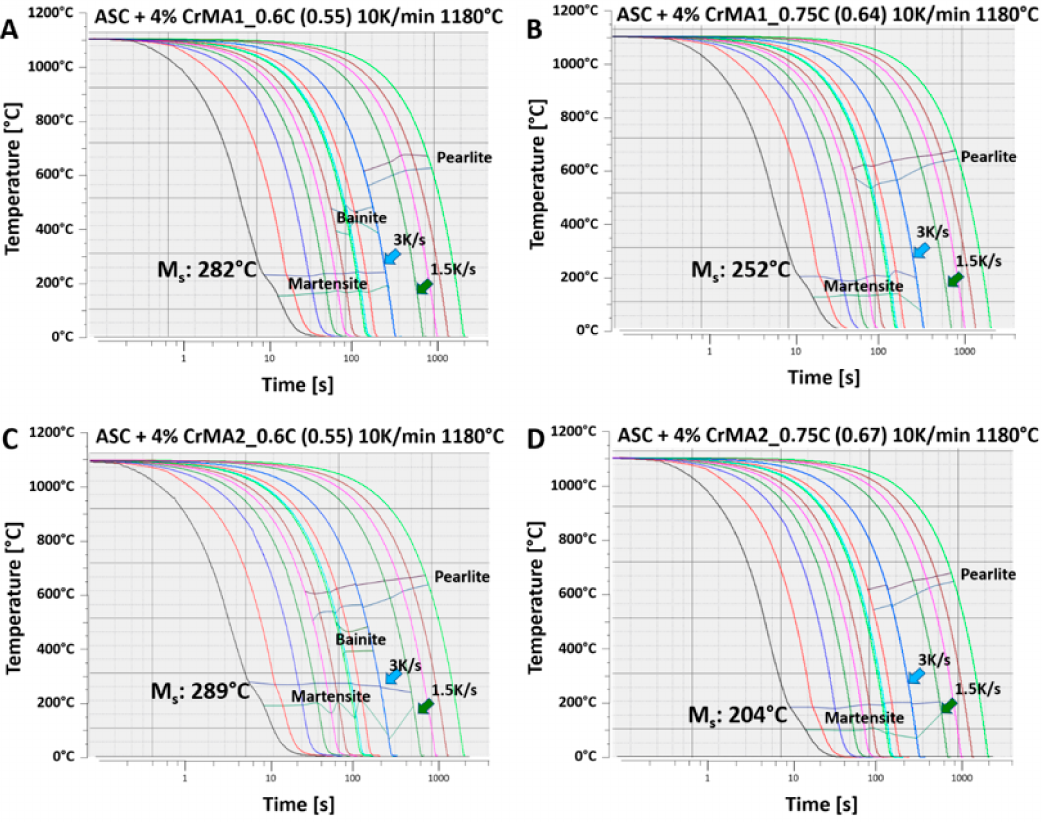
Figure 9. CCT diagrams recorded from a single sample with 14 runs each. Heated at 11 K/s to 1100 ◦ C and held for 300 s, cooled with different rates. (A) ASC + 4%CrMA1_0.6C nom (0.55C comb ), (B) ASC + 4%CrMA1_0.75C (0.64C), (C) ASC + 4%CrMA2_0.6C (0.54C), (D) ASC + 4%CrMA2_0.75C